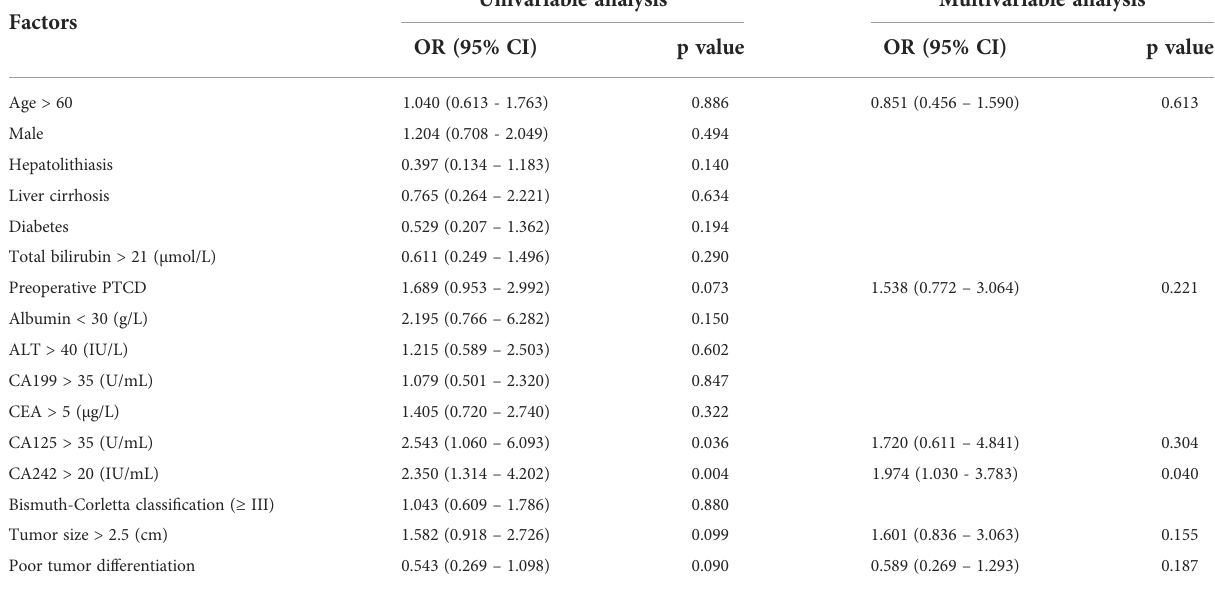
TABLE 3 Univariable and multivariable analysis of risk factors associated with lymph nodes metastasis.